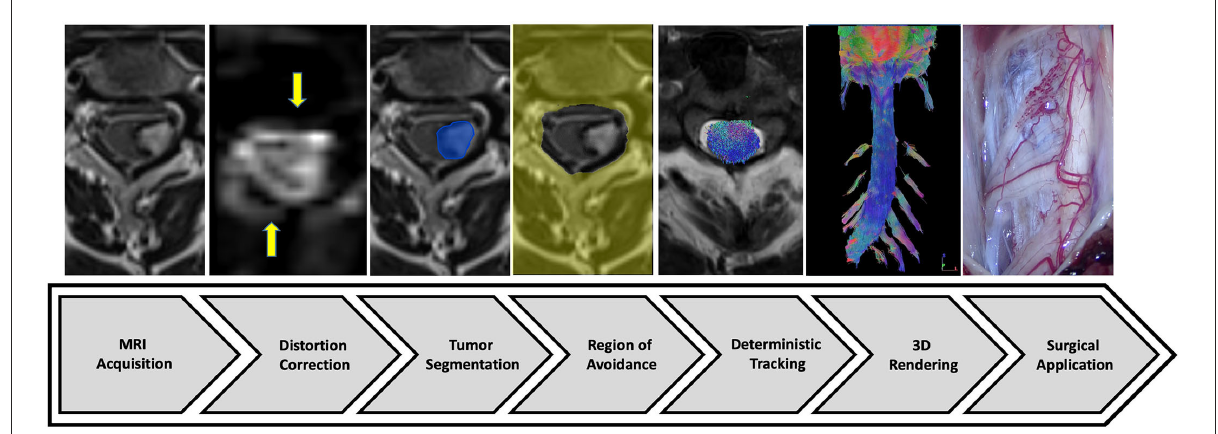
FIGURE1 Study diagram. From Philips MRI machine, diffusion tensor imaging associated with T2-weighted imaging (and enhanced T1-weighted imaging if necessary) were acquired (step 1). The post-processing protocol included distortion correction (step 2), tumor segmentation (step 3), and region of avoidance design (step 4). The tracking process (step 5) was performed using the DSI-Studio software to visualize a 3D full cervical spinal cord tractography (step 6) to help neurosurgical management (step